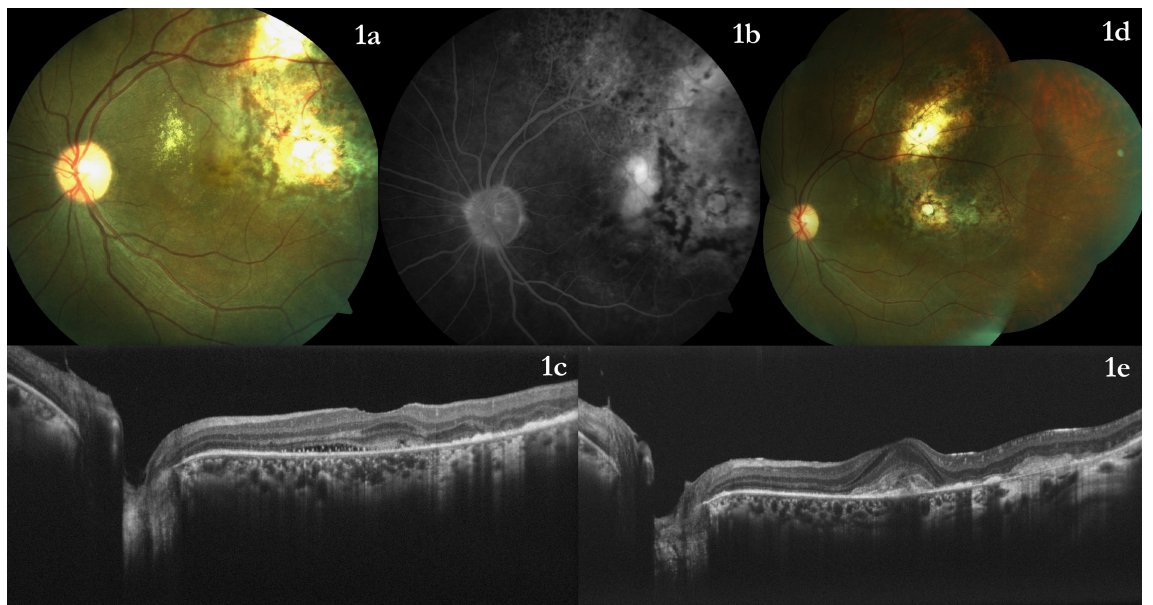
Figure 1: a) The left eye showed a healed choroidal tuberculoma with macular hard exudates, subretinal fluid and subretinal bleed. b) The fluorescein angiogram showed an active choroidal neovascular membrane. c) The optical coherence tomography (OCT) showed subretinal fluid. d) At 1 month, the hard exudates had reduced considerably and subretinal bleed had resolved. e) The optical coherence tomography showed a subretinal scar with no intraretinal or subretinal fluid at any macular scan. [Modified from [4] with kind permission from Taylor and